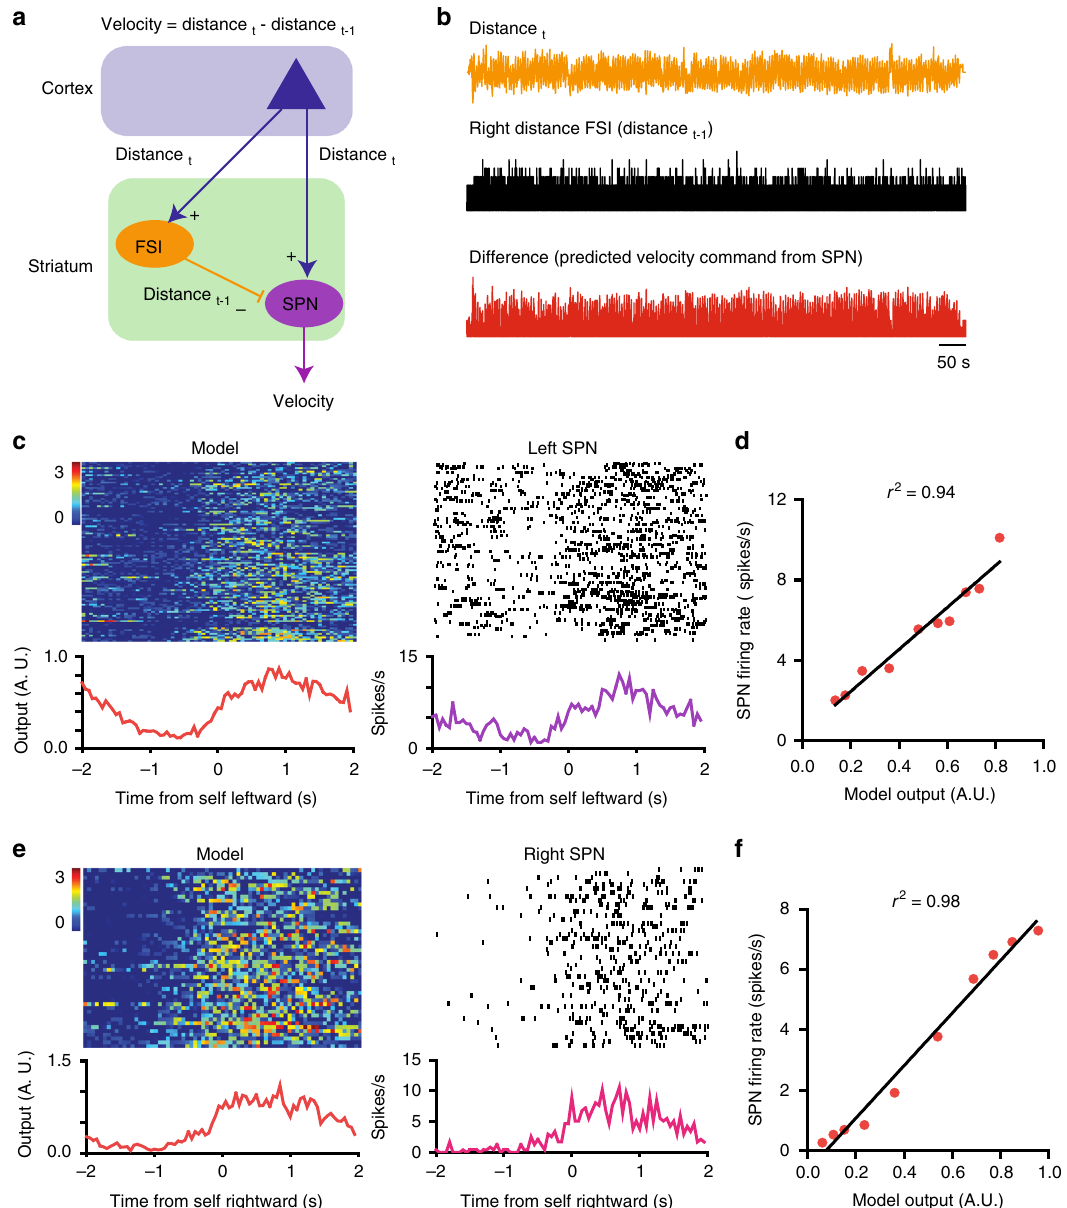
Fig. 7 Working model of how FSI – SPN circuit contributes to continuous pursuit. a Schematic diagram of the FSI – SPN feedforward inhibition circuit. Note that in the equation for velocity, distance refers to distance to target. This equation only applies to self-velocity during continuous pursuit. As shown here, excitatory cortical inputs reach both the FSI and SPN. In this case, some excitatory input represents distance to target, a key error signal used to guide pursuit behavior, and the FSI relays a slightly delayed version of the same signal to the SPN. Thus the delayed distance signal (Distance t − 1 ) is subtracted from the distance signal (Distance t ), and the SPN output re fl ects the difference between these two signals, i.e. the change in distance in this time step. As the feedforward inhibition circuit can function as a differentiator, the velocity command is proportional to the change in distance in a direction-speci fi c manner. b Actual traces from our experiments illustrating the variables used in the model. c The model is compared with actual data using simultaneously recorded left distance FSI and left velocity SPN from the same mouse (same hemisphere). Using actual distance measure as an estimate of the Distance t signal (shifted by 100 ms to account for the delay in the perceptual system) sent to the striatum, and FSI activity as the measure of the Distance t − 1 signal sent to the SPN, a subtraction generates a difference signal (model) that is compared to the activity of an actual left velocity SPN. d Model output is highly similar to right velocity SPN output (Pearson ’ s r , p < 0.0001. e Same as c , except that the model is generated using a right distance FSI. The model is compared with actual data using simultaneously recorded right distance FSI and right velocity SPN. f High correlation between model output and right velocity SPN output ( p < 0.0001). Source data are provided as a Source Data fi (Motion Analysis) online to control reward delivery based on mouse behavior. re fl ective markers (6.35 mm diameter) were used for tracking mouse and target Reward (~12 μ l of 20% sucrose) was delivered every 800 ms during following. Prior movements. One marker was located on the wireless recording headstage and to the recording sessions, all mice were trained until they followed the target another was ~20mm from the sucrose spout. These markers were captured by consistently (2 – 4 h of training over 1 week). In most experiments, the target moved eight Raptor-H Digital Cameras (Motion analysis, CA, 100 Hz sampling rate). The at a constant velocity (16 mm/s). On some sessions, however, target velocity was data was transformed into Cartesian coordinates ( x , y , and z ) by the Cortex pro- varied randomly (5 – 48 mm/s, updated every 2ms by MATLAB). gram (Motion Analysis, CA). MATLAB communicated with the Cortex program